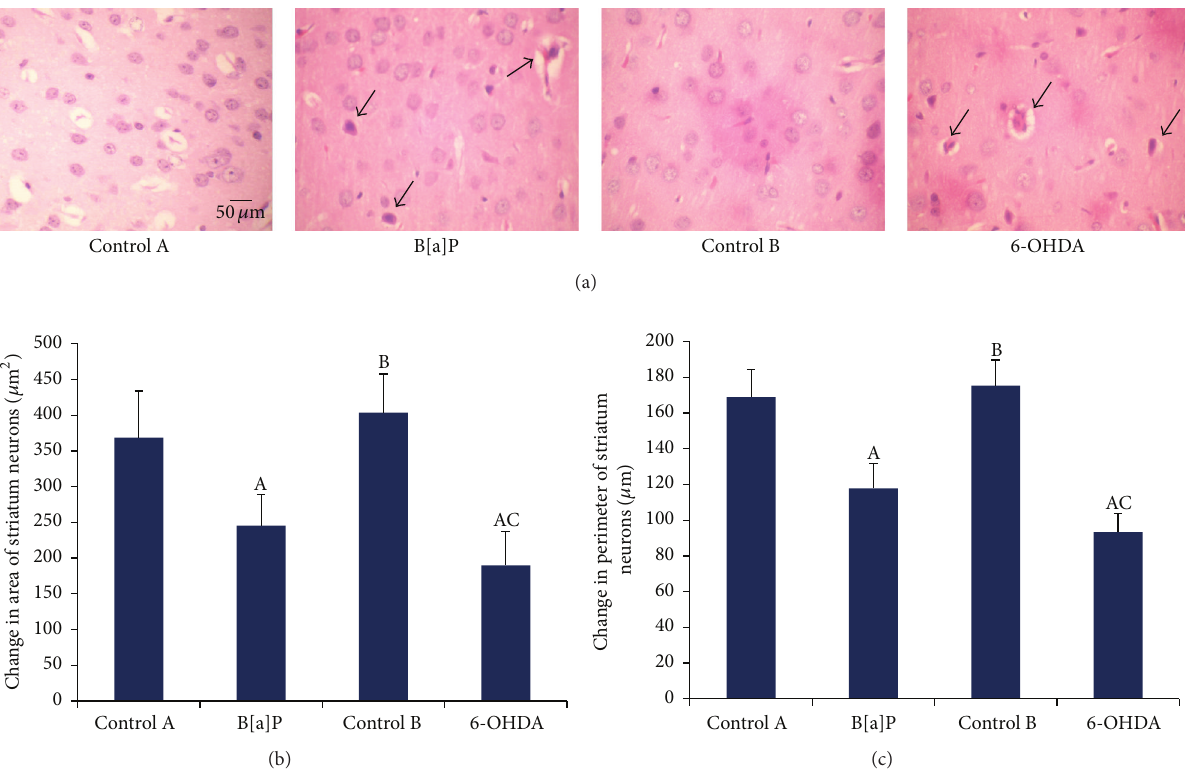
Figure 5: Histopathological study by hematoxylin and eosin staining. Representative microscopic images of hematoxylin and eosin staining of striatal neurons (a). Magnification at 10x (scale bar = 50 𝜇 m). Arrow head depicts degenerative neurons. Histogram represents striatal neuronal area and perimeter ((b) and (c)). Values are expressed as mean ± SEM ( 𝑛 = 6 /group). “A” denotes 𝑝 < 0.05 when compared to control A group, “B” denotes 𝑝 < 0.05 when compared to B[a]P group, and “C” denotes 𝑝 < 0.05 when compared to control B